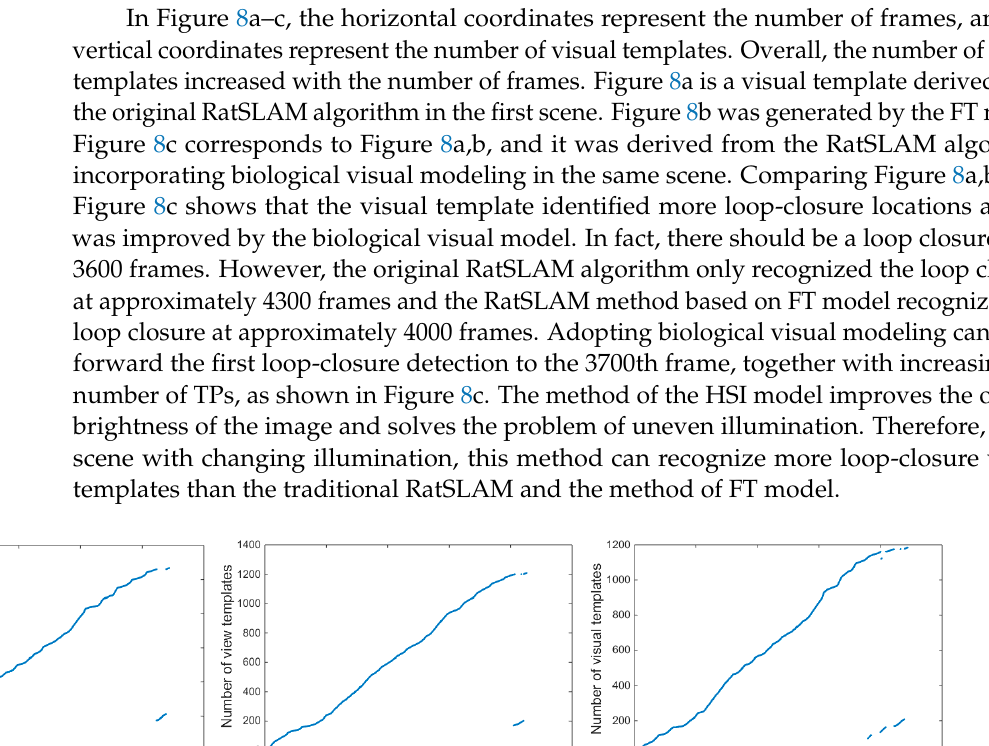
Figure 7. Schematic of the mechanical building.